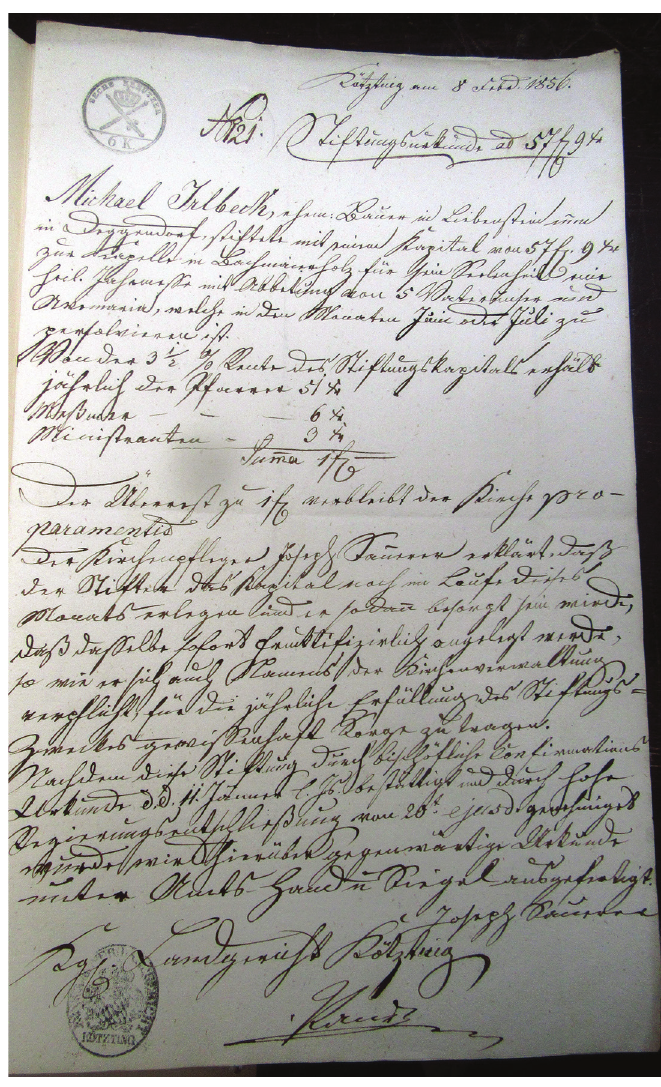
Figure 2: Irlbeck ’ s capital endowment for the Bachmeierholz chapel dated 8 February 1856, Source: StALa, Landgericht ä .O. K ö tzting, Nr. 355,